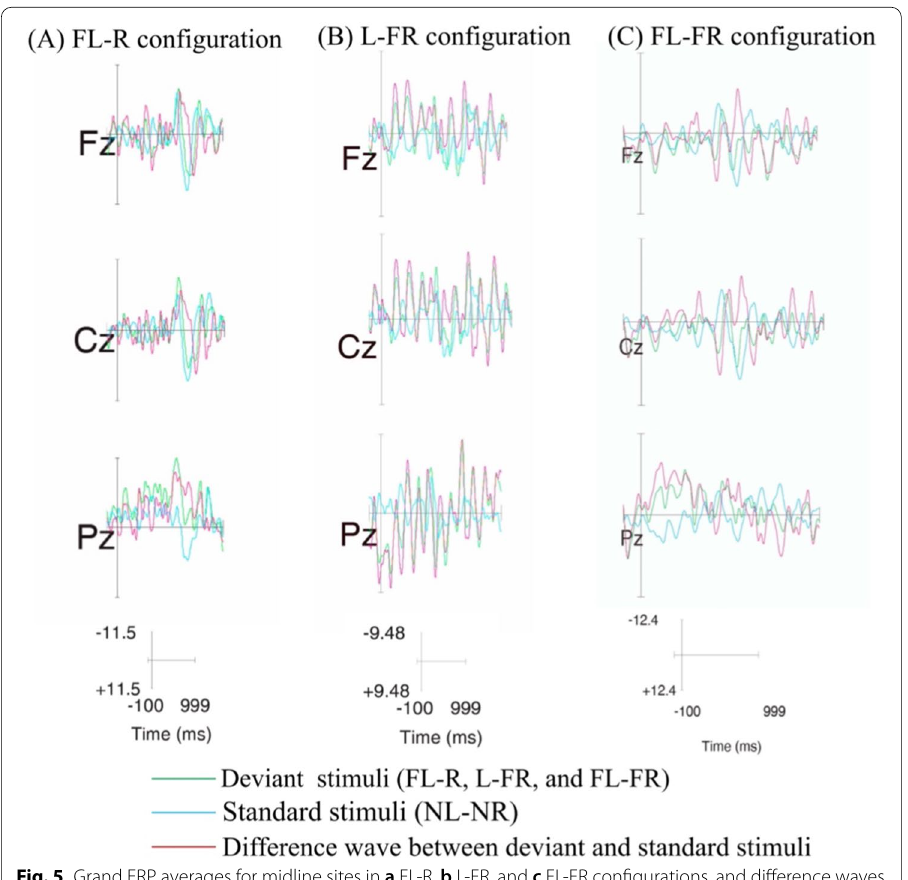
Fig. 5 Grand ERP averages for midline sites in a FL-R, b L-FR, and c FL-FR configurations, and difference waves between deviant and standard